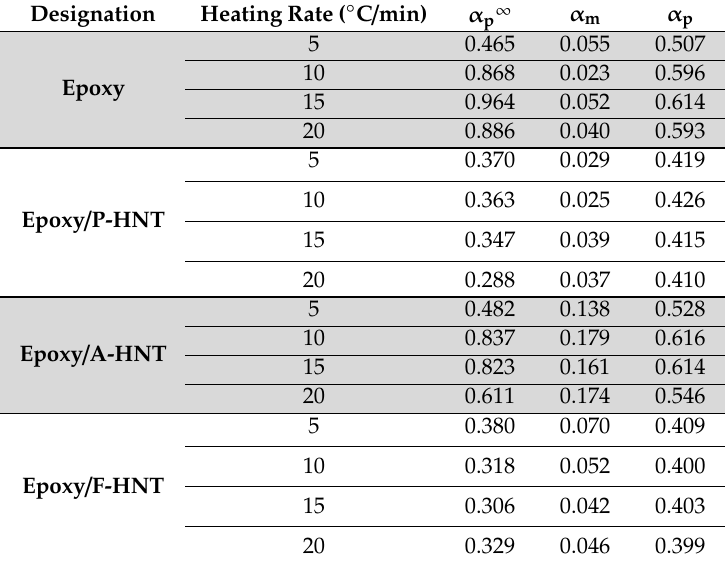
Table 1. The values of α p , α m and α p ∞ obtained from DSC analysis based on Malek model at various heating